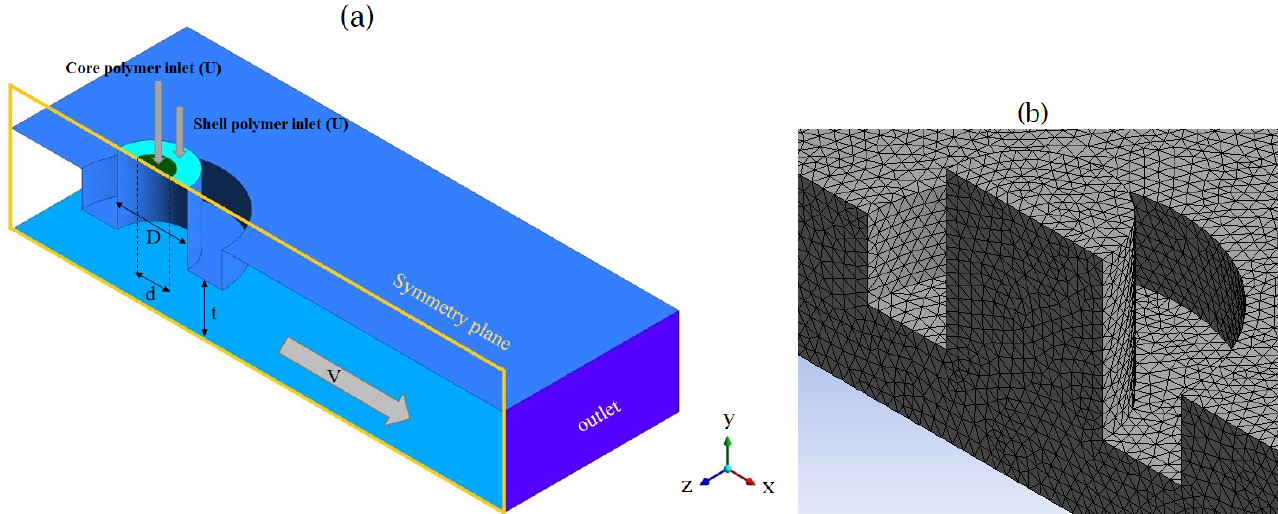
Figure 3. ( a ) Geometry of the computational domain, and ( b ) example of a tetrahedral mesh used in the